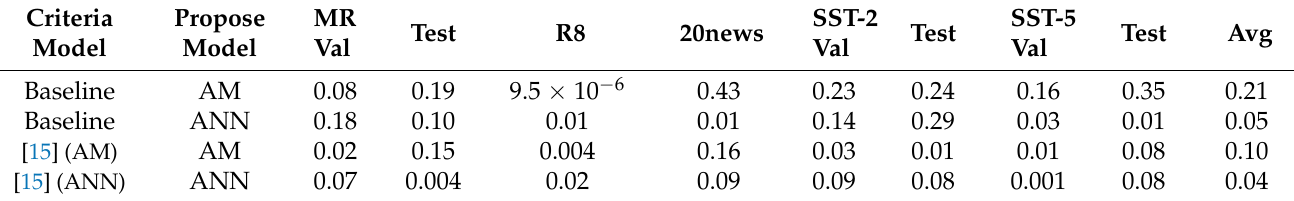
Table 6. p -value between the proposed model and the baseline, or